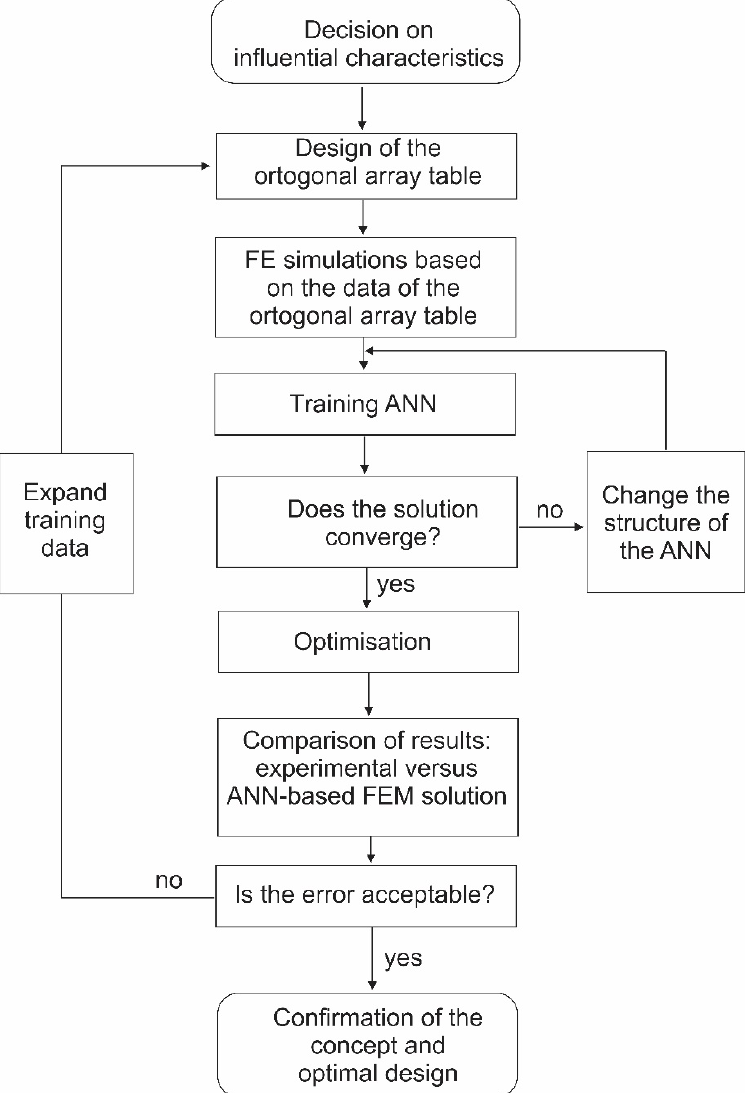
Figure 2. Flow chart of the performed research work.